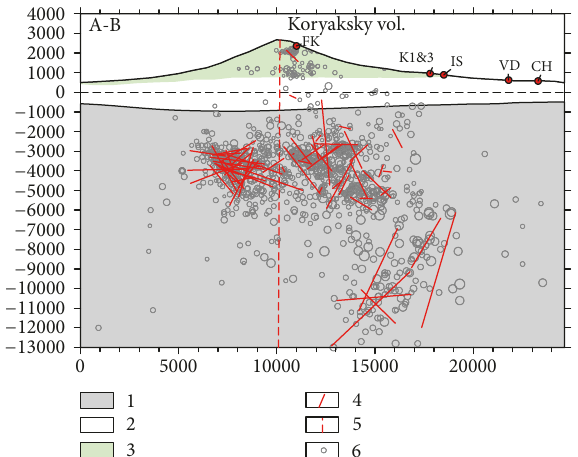
Figure2:Geologicalcross-sectionalAB(seeFigure 1).( 1 )Basement with metamorphic Upper Cretaceous K 2 rocks in its upper part; (2) Miocene (N 1 )-Quaternary aquifer complex; (3) Koryaksky Volcano (or/and Avachinsky Volcano in Figures 3 and 4); (4) traces of dikes and sills, defined from plane-oriented MEQ clusters; (5) assumed main feeding magma channels of Koryaksky Volcano (or/and AvachinskyVolcanoinFigures3and4);(6)earthquakehypocenters, in which their sizes are proportional to their magnitudes (KB GS RAS data 2001–2016). The ticks along the axes represent intervals of 1km, and axes are labeled in meters.